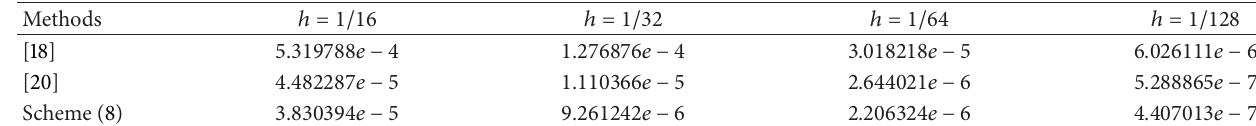
Table 2: The maximal errors of numerical solutions at 𝑡 = 10 , 𝜏 = 0.1 , 𝛽 = 1 , 𝛼 = 2 , and 𝑝 = 4 .